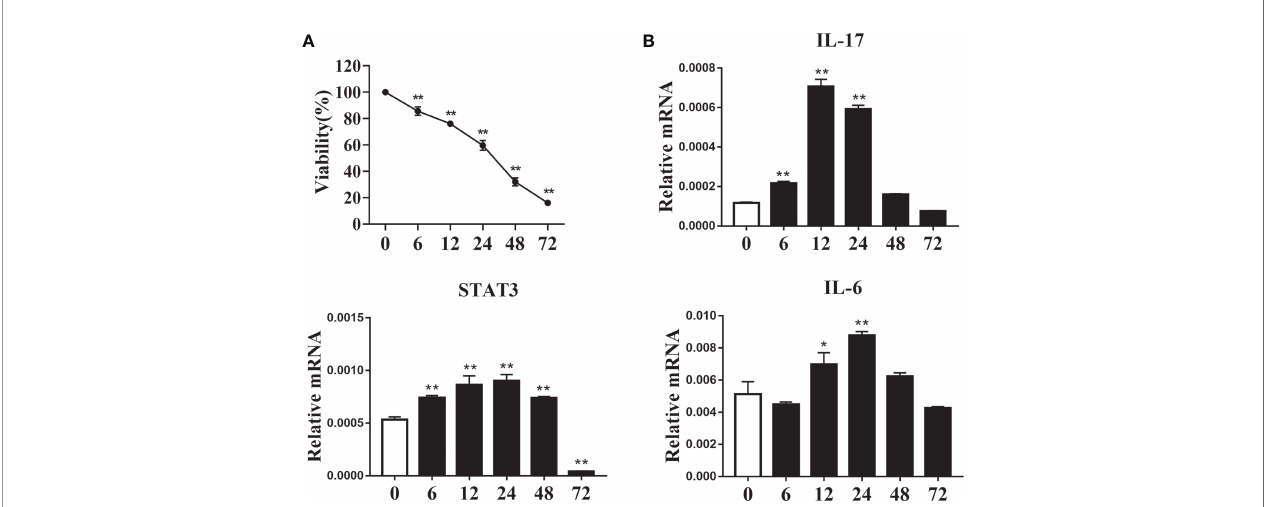
FIGURE 5 | Exogenous fatty acids induced cell damage and increased expression of Th17 cells related factor. CD4 + T cells were sorted from spleens from 1-d old calves and treated with 1.2 mM fatty acids for 0, 6, 12, 24, 48 and 72 h (A) Cell viability was detected by CCK-8 kit (n = 4 per group). (B) Relative mRNA expression of IL-17, STAT3 and IL-6 (n = 4 per group). Comparisons among groups were calculated using a one-way ANOVA with a Duncan correction. The data presented are the mean ± SEM, *P ≤ 0.05, **P ≤